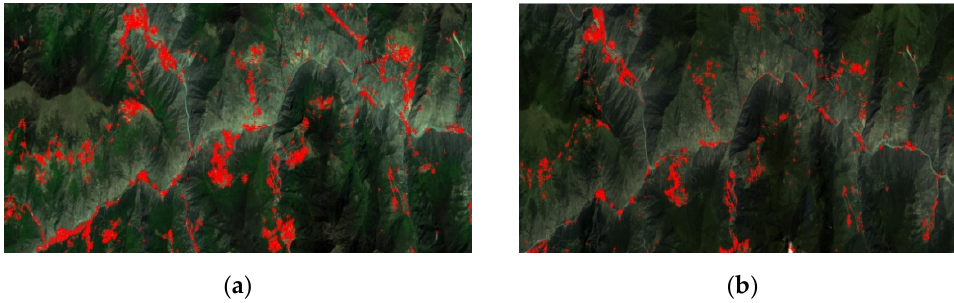
Figure 5. The extracted feature points in the GF-1 image pair: ( a ) acquired on 19 February 2015; ( b ) acquired on 11 May 2015.